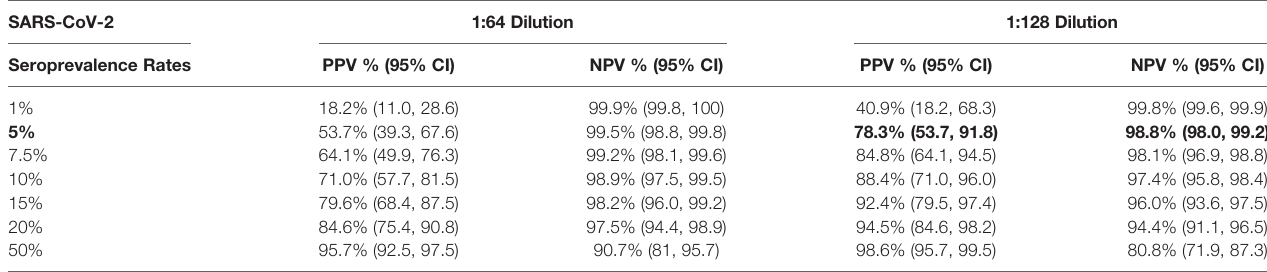
TABLE 2 | Positive predictive value (PPV) and negative predictive value (NPV) of SARS-CoV-2 IgA at different SARS-CoV-2 seroprevalence rates. SARS-CoV-2 1:64 Dilution 1:128 Dilution Seroprevalence Rates